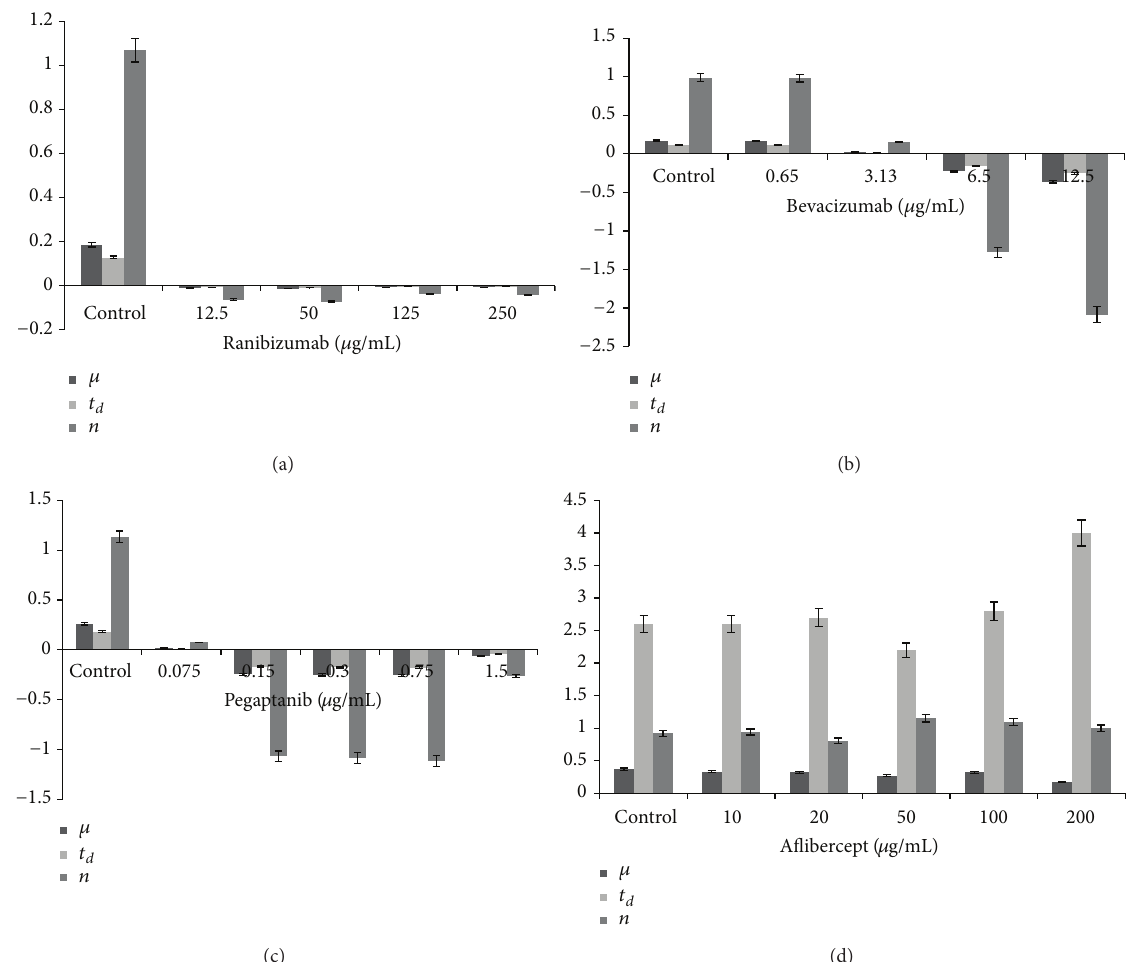
Figure 8: Comparison of the cellular growth kinetics in L929. Specific growth velocity ( 𝜇 ), population doubling time ( 𝑡 𝑑 ), and cell reproduction velocity ( 𝑛 ) are shown under treatment with ranibizumab (a), bevacizumab (b), pegaptanib (c), and aflibercept (d) at different concentrations (data shown are at Day 5 of the treatment; 𝑛 = 3 ).